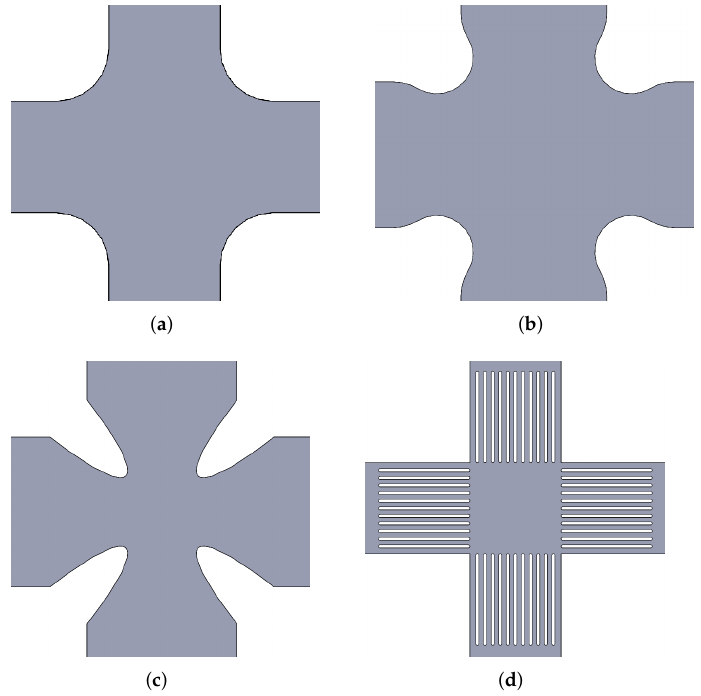
Figure 2. Schematisation of the most frequently used geometrical features in cruciform specimens: ( a ) Single radius corner. ( b ) Double radii filleted corner. ( c ) Elliptical corner. ( d ) Slotted